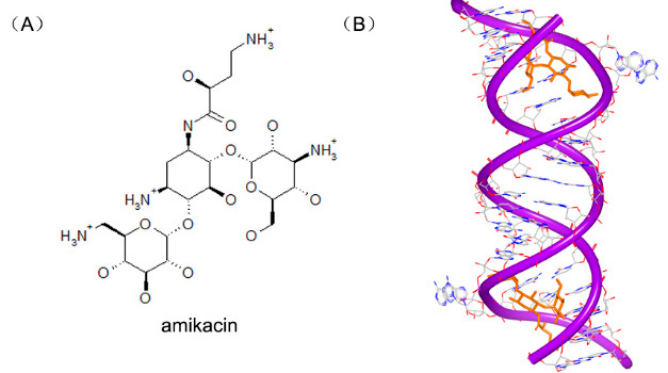
Figure 21. ( A ) Chemical structure of amikacin; and ( B ) complex of a RNA duplex with amikacin (PDB code: 4P20). The orange structure represents the small molecule; the purple structure represents the backbone of nucleic acid; the blue and red atoms in the molecule represent nitrogen and oxygen atoms, respectively.